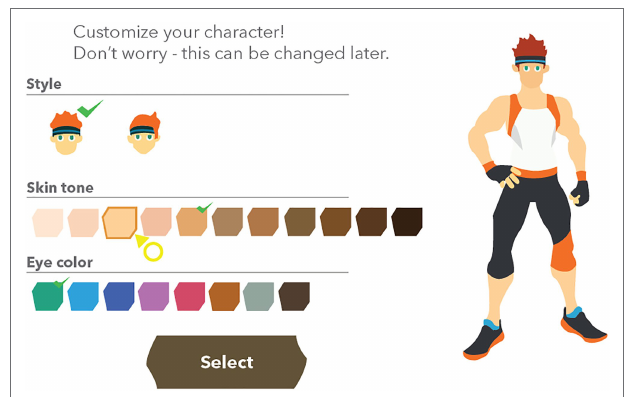
FIGURE 1 | Depiction of the Avatar Customization in Ring Fit Adventure (Nintendo